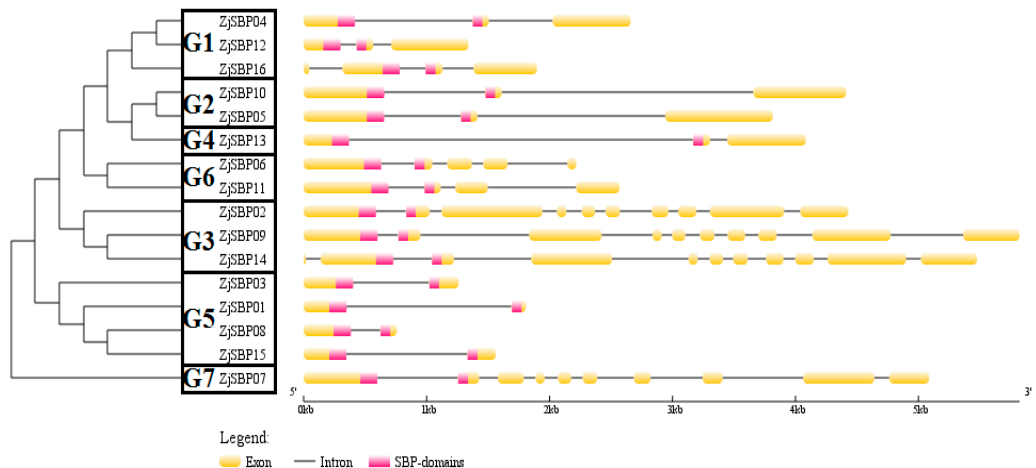
Figure 4. Phylogenetic analysis of jujube SBP domain proteins and exon-intron structures with the online Gene Structure Display Server. Exons and SBP domains are indicated by yellow and pink boxes. Black lines connecting two exons represent introns.